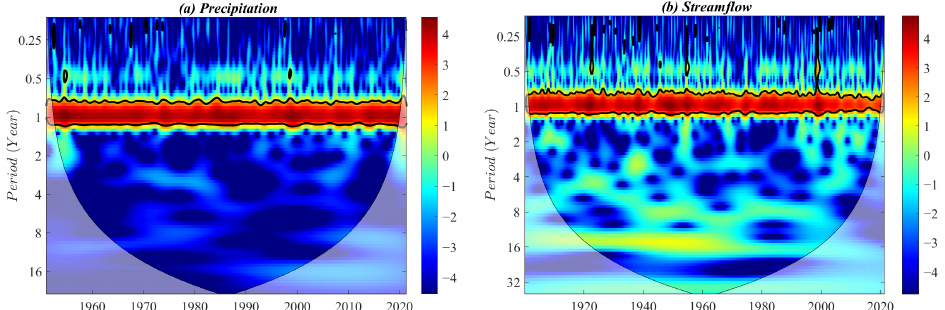
Figure 3. Continuous wavelet power spectrums of monthly precipitation and streamflow